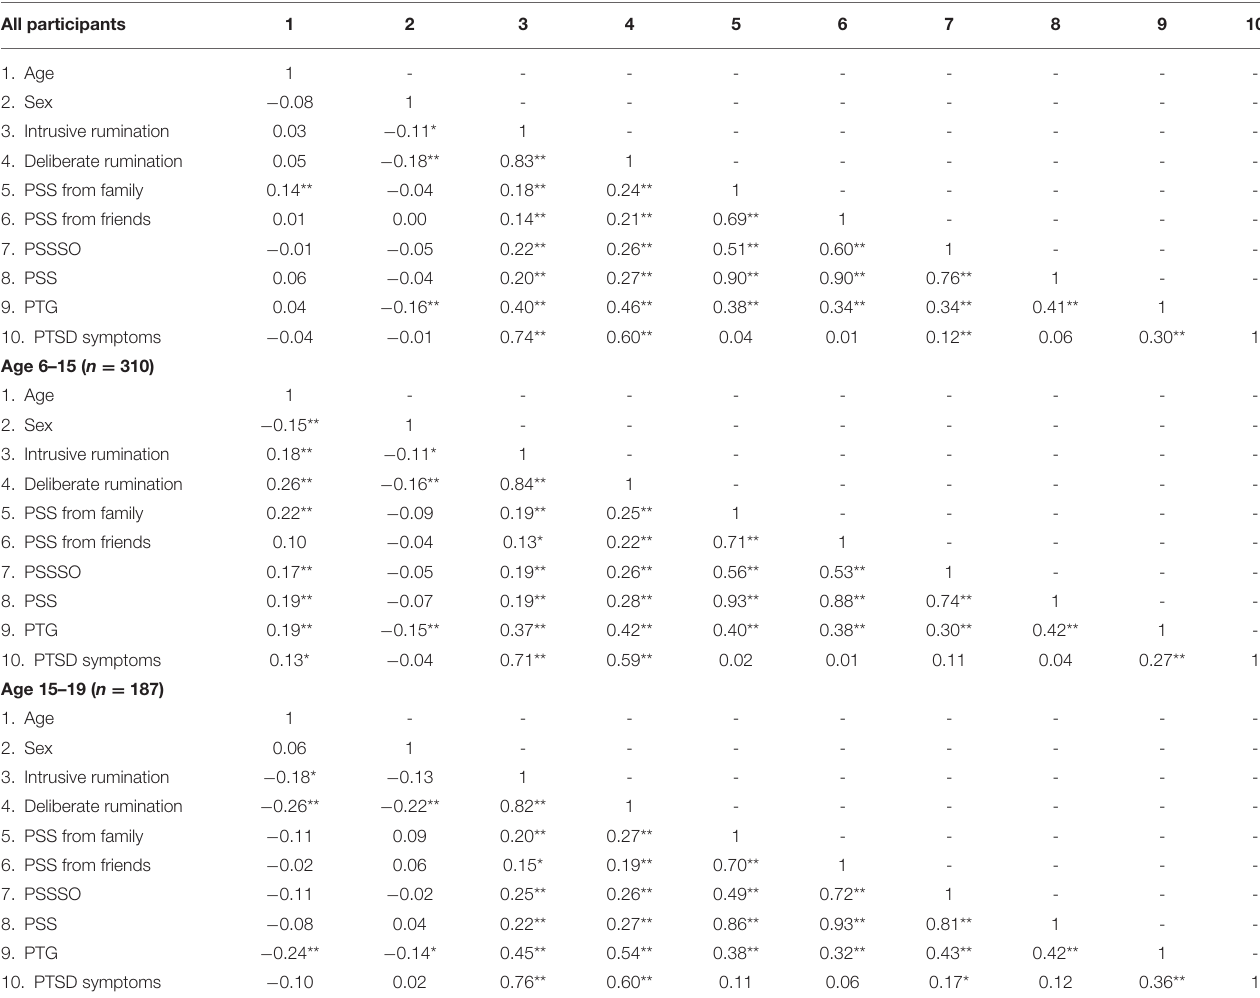
TABLE 2 | Correlations of variables of Wenchuan earthquake youth survivors. All